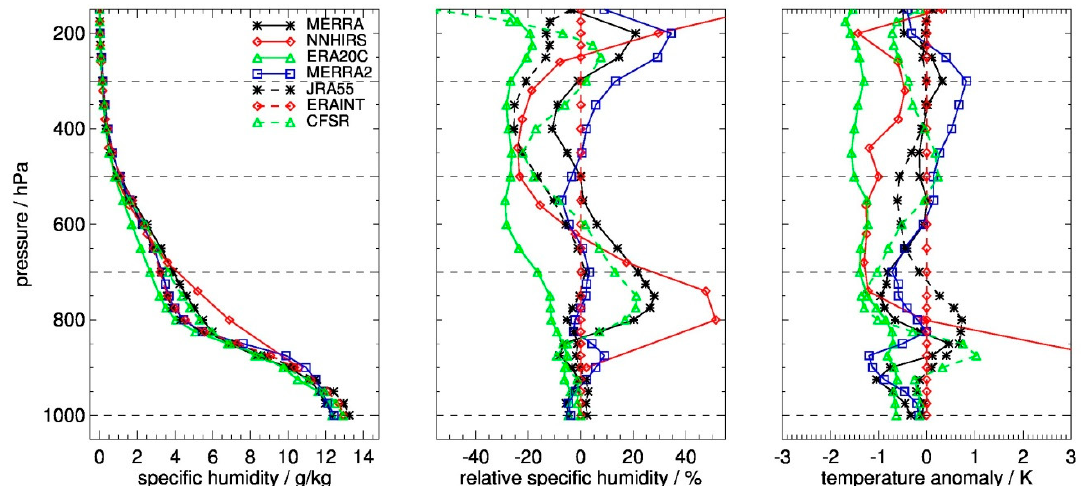
Figure 8. Average profiles of absolute and relative specific humidity ( left and middle , respectively) and of temperature ( right ). The profiles were averaged over the period DJF and over the region marked with a black box in Figures 5 and 6. (Sc Pacific). Dashed horizontal lines mark the pressure levels 300, 500, 700 and 1000 hPa. All water vapour profile data records of the G-VAP data archive were utilised. Basis for all plots was data from the period January 1988–December 2009.